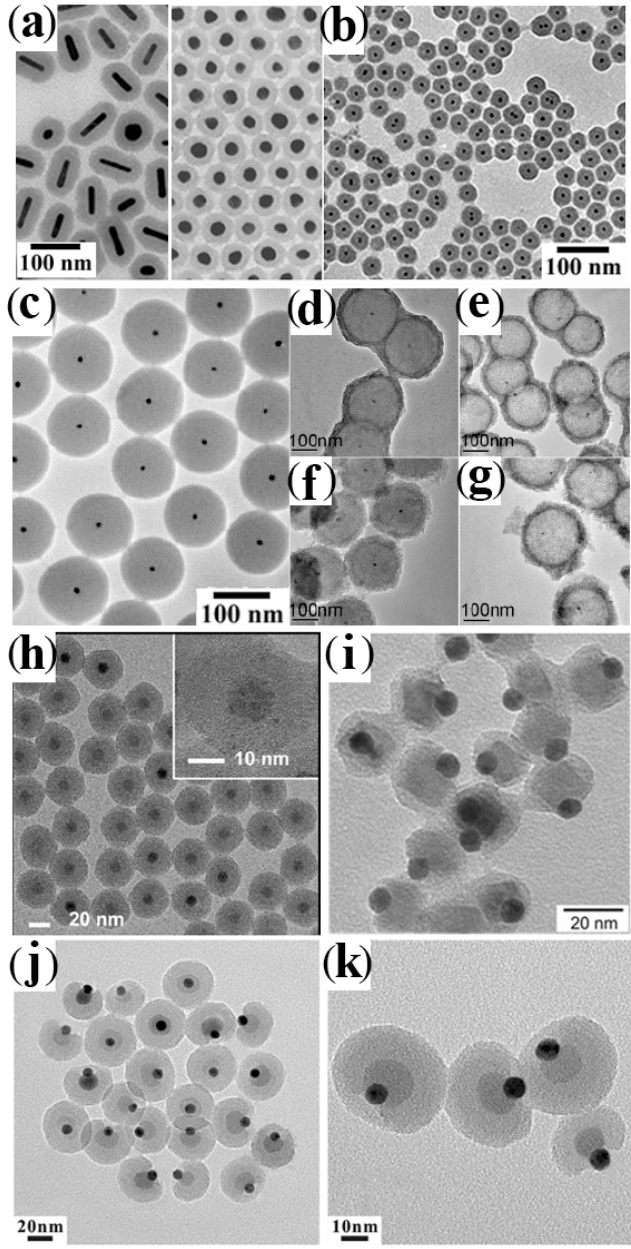
Figure 3. Gallery of representative core@SiO 2 -shell CNHSs synthesized after pre-activating the surface of the seed cores and then overgrowing silica (cf. Scheme 2c). The panels report TEM overviews of: ( a ) Au@SiO 2 CNHSs with different shapes (reproduced with permission from Ref. [141], Copyright 2006, American Chemical Society); ( b ) FePt@SiO 2 CNHs (reproduced with permission from Ref. [143], Copyright 2006, American Chemical Society); ( c ) Au@SiO 2 core@shell CNHSs and